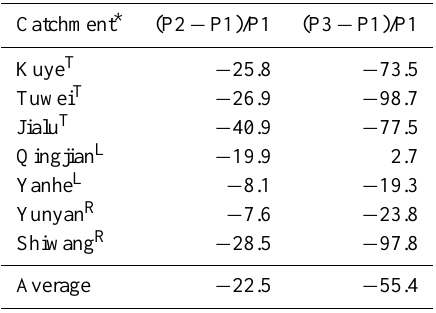
Table 7. Reduction of the linear regression coefficients for the monthly sediment load and streamflow in the catchments